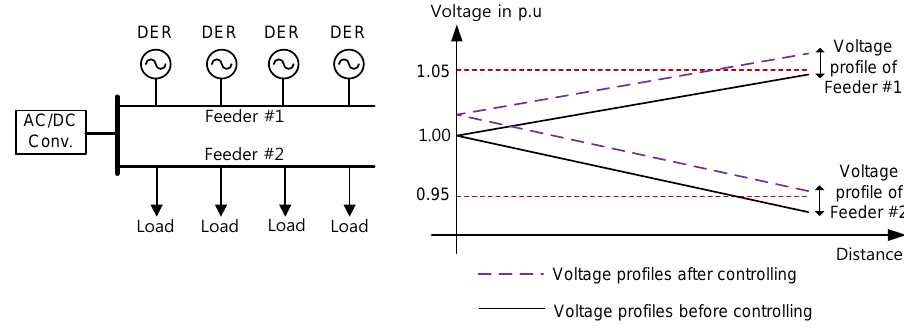
Figure 2. Voltage profile variations in the DC distribution system.